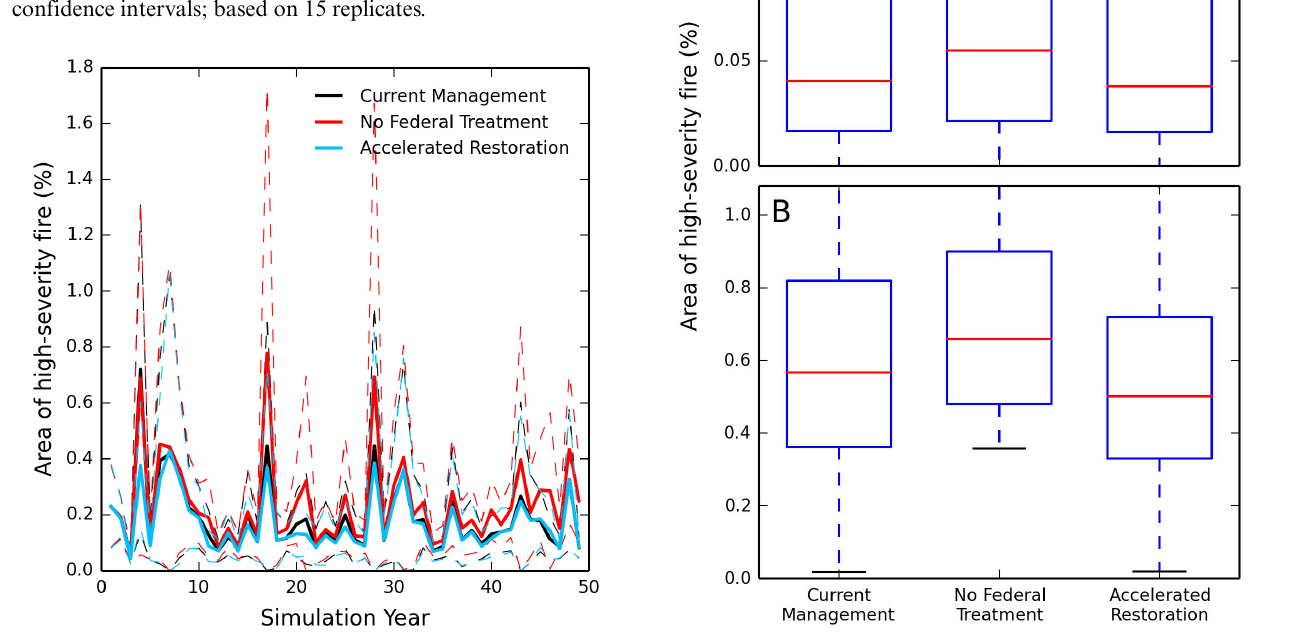
Fig. 3. Mean annual area (%) of high-severity fire for current management, no federal treatment, and accelerated restoration scenarios over time across all forested potential vegetation types and ownerships. Broken lines indicate corresponding 95% confidence intervals; based on 15 replicates.